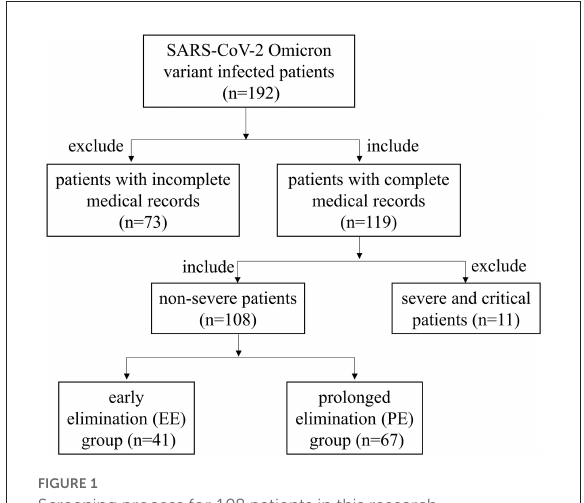
FIGURE1 Screening process for 108 patients in this